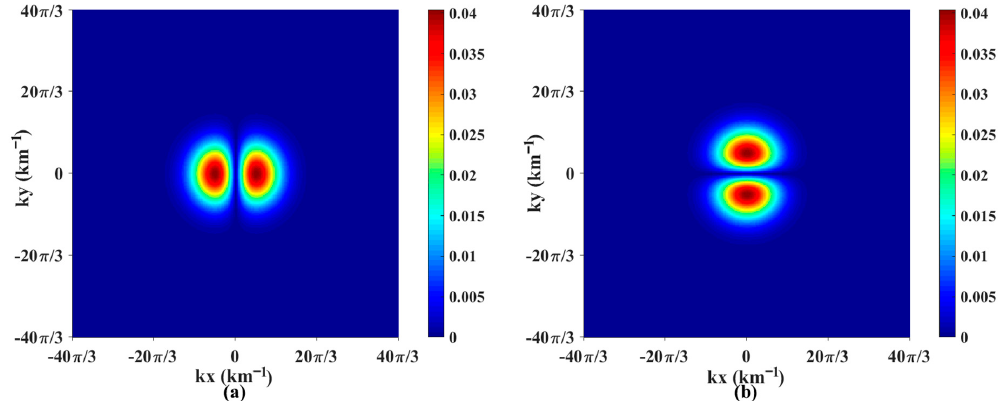
Figure 3. The amplitude distributions of (cid:1834) (cid:1876) ( a ) and (cid:1834) (cid:1877) ( b ), σ is 15.